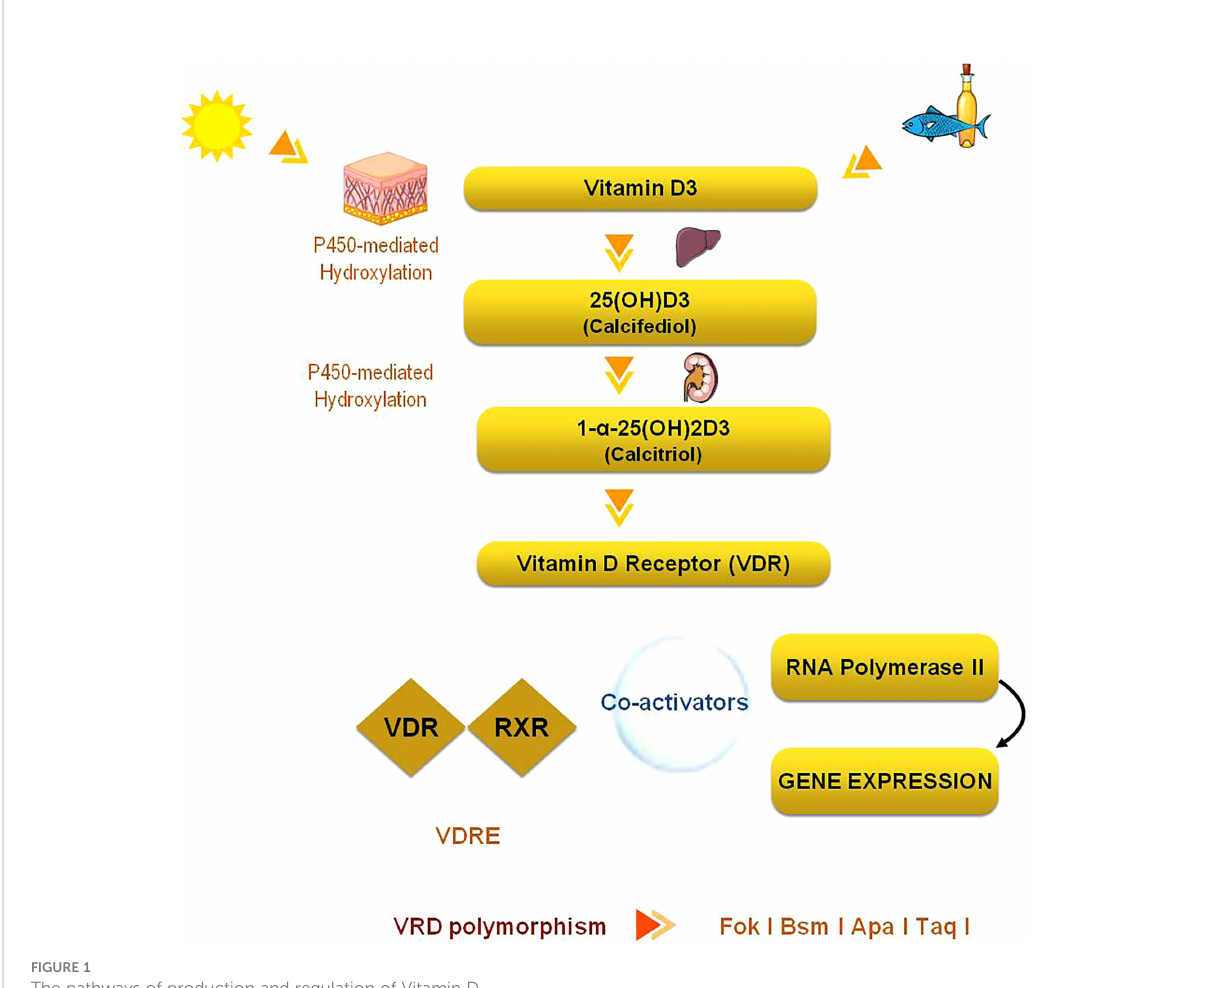
FIGURE 1 The pathways of production and regulation of Vitamin